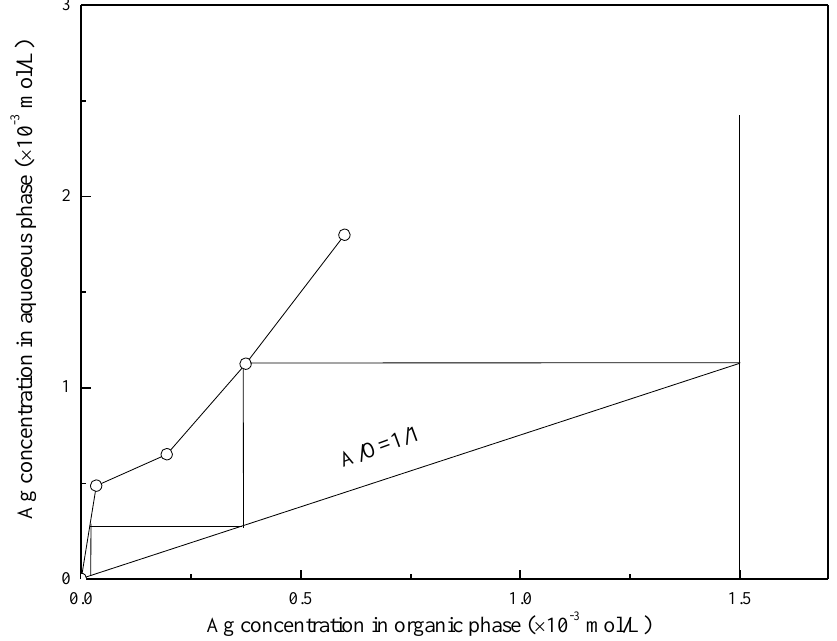
Figure 8. McCabe–Thiele plot for the stripping of Ag(I) using 0.1 mol/L thiourea. Figure 8. McCabe – Thiele plot for the stripping of Ag(I) using 0.1 mol/L thiourea. Compared to the reported results (Table 1) [31], the purity of Cu(II) in the recovered solution was low (95.2%); however, by using the present process, Cu(II) and Ag(I) can to verify the results obtained from the McCabe – Thiele diagram. The loaded LIX63 after the removal of Cu(II) using 4 mol/L HNO 3 at an A/O ratio of 2:1 in one stage was used. After the two-stage counter-current stripping using 0.1 mol/L thiourea at an A/O ratio of 1:1, 99.2% of Ag(I) was stripped. The concentration of Ag(I) in the obtained stripping so- lution was 1.34  10 − 3 mol/L. This indicated that the purity of Ag(I) was higher than 99.993% (detection limit: 0.01 mg/L).